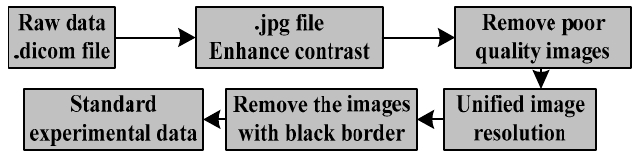
Figure 4. The flowchart of preprocessing.